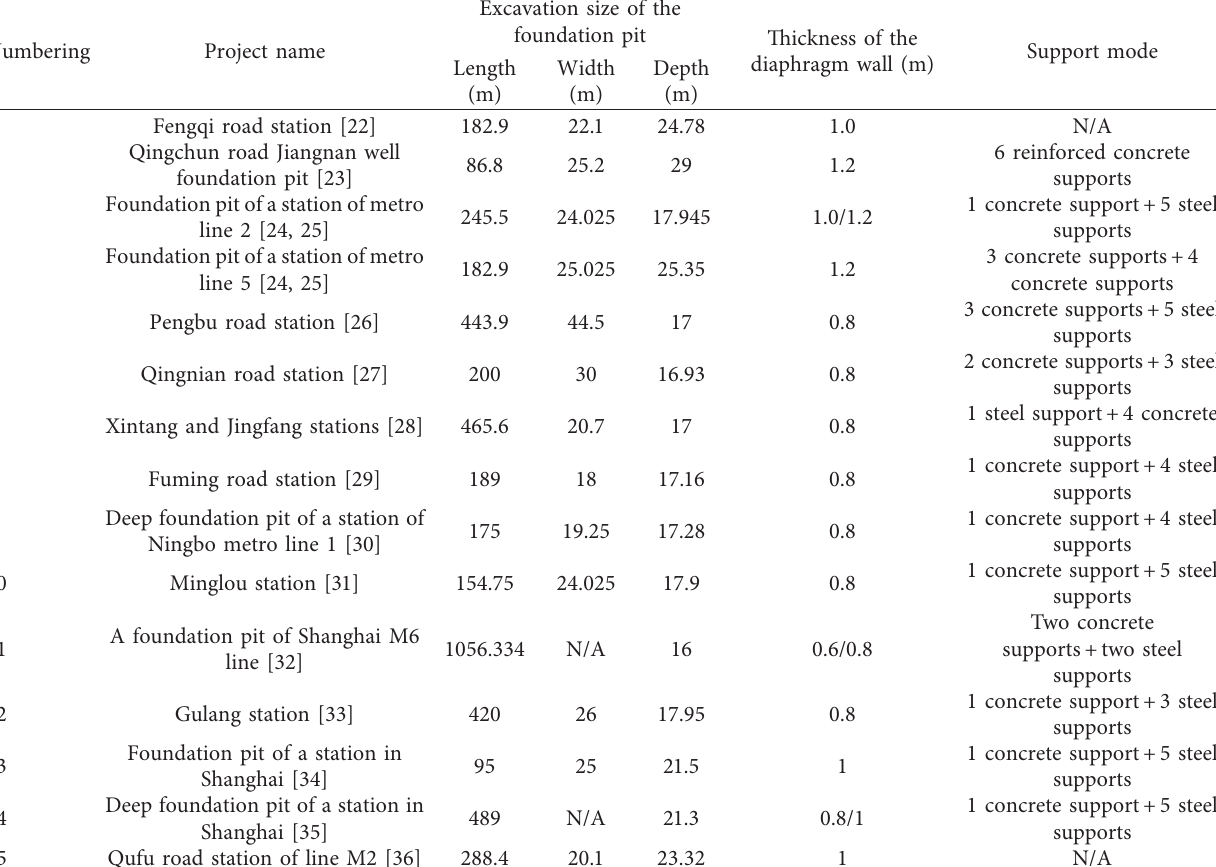
Table 2: Statistics of basic deformation information of the deep foundation pit of the